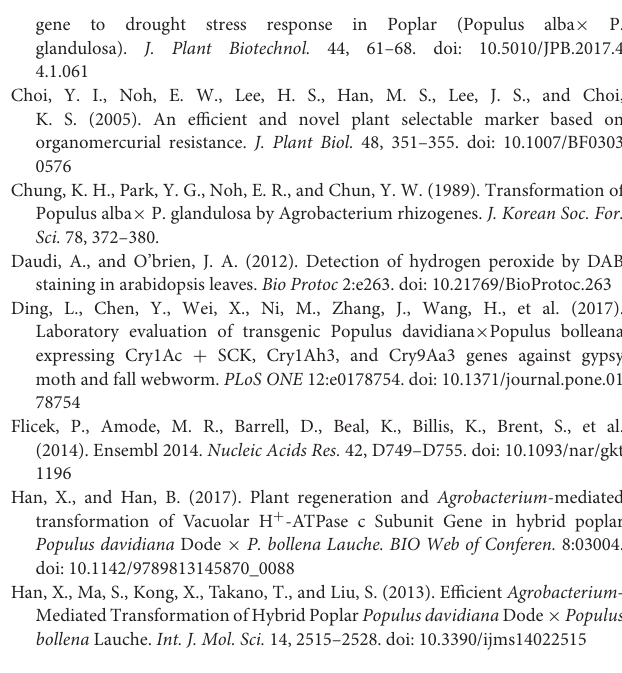
significance, at least two-fold change in their expression, and contrasting expression patterns in the drought and susceptible cultivars, following dehydration stress were identified. Different DEGs were expressed only in the drought-resistant cultivars but not in the susceptible cultivars. On the other hand, multiple DEGs were either downregulated in the drought-tolerant cultivars (downward blue arrows) but upregulated in the susceptible cultivars or vice versa . Supplementary Figure 2 | Independent PdNCED3 OE and RNAi transgenic lines. Eight (8) independent PdNCED3 OE lines and seven (7) independent RNAi lines were obtained (A) . NCED3 expression in the WT, RNAi, and OE lines under normal conditions (B) . NCED3 expression in the WT, RNAi, and OE lines after 10, 20, and 30min of drought stress treatment (C) . Supplementary Figure 3 | Amino acid sequence alignment of PdNCED3. Amino acid sequence alignment of PdNCED3 (Potri.011G112400) from the four cultivars under the study with NCED3 from P. trichocarpa , P. glandulosa , Arabidopsis thaliana , and the consensus sequence. Supplementary Figure 4 | Amino acid sequence alignment of PdNCED1. Amino acid sequence alignment of PdNCED1 (Potri.001G393800) from the four cultivars under the study with NCED1 from P. trichocarpa , P. glandulosa , and the consensus sequence. Supplementary Figure 5 | Predicted PdNCED1 3D structure and potential Co-factors. PdNCED1 (Potri.001G393800) peptide from the drought-tolerant cultivars, Palgong 2 and Seogwang 9 showed iron (Fe/Fe 2 + ) as potential co-factor whereas, Palgong 1 and Junguk 6–2 showed tetraethylene glycol monooctyle ether (C8E) as a potential co-factor ligand. The predicted 3D structure, associated co-factor, and ligand binding sites information with the highest C-Score were selected. Supplementary Figure 6 | Stomatal aperture and water loss measurements. Measurements of stomatal aperture in the leaves of the drought-tolerant and drought susceptible P. davidiana cultivars (A) . Measurements of stomatal aperture in the leaves of the P. davidiana WT, OE, and RNAi lines (B) . Water loss measurements from the leaves of P. davidiana WT, OE, and RNAi lines (C) . Supplementary Figure 7 | Generation of transgenic Poplar plants via tissue culture. Supplementary Table 1 | List of primers used for